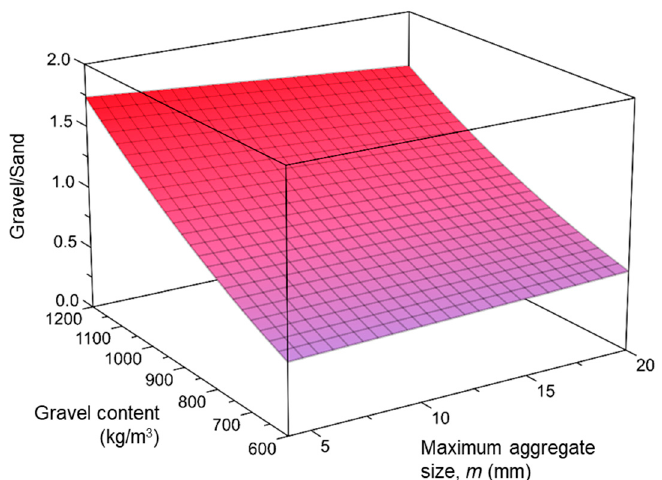
Figure 2. Coarse-to-fine aggregate ratio versus aggregate content and maximum aggregate size.